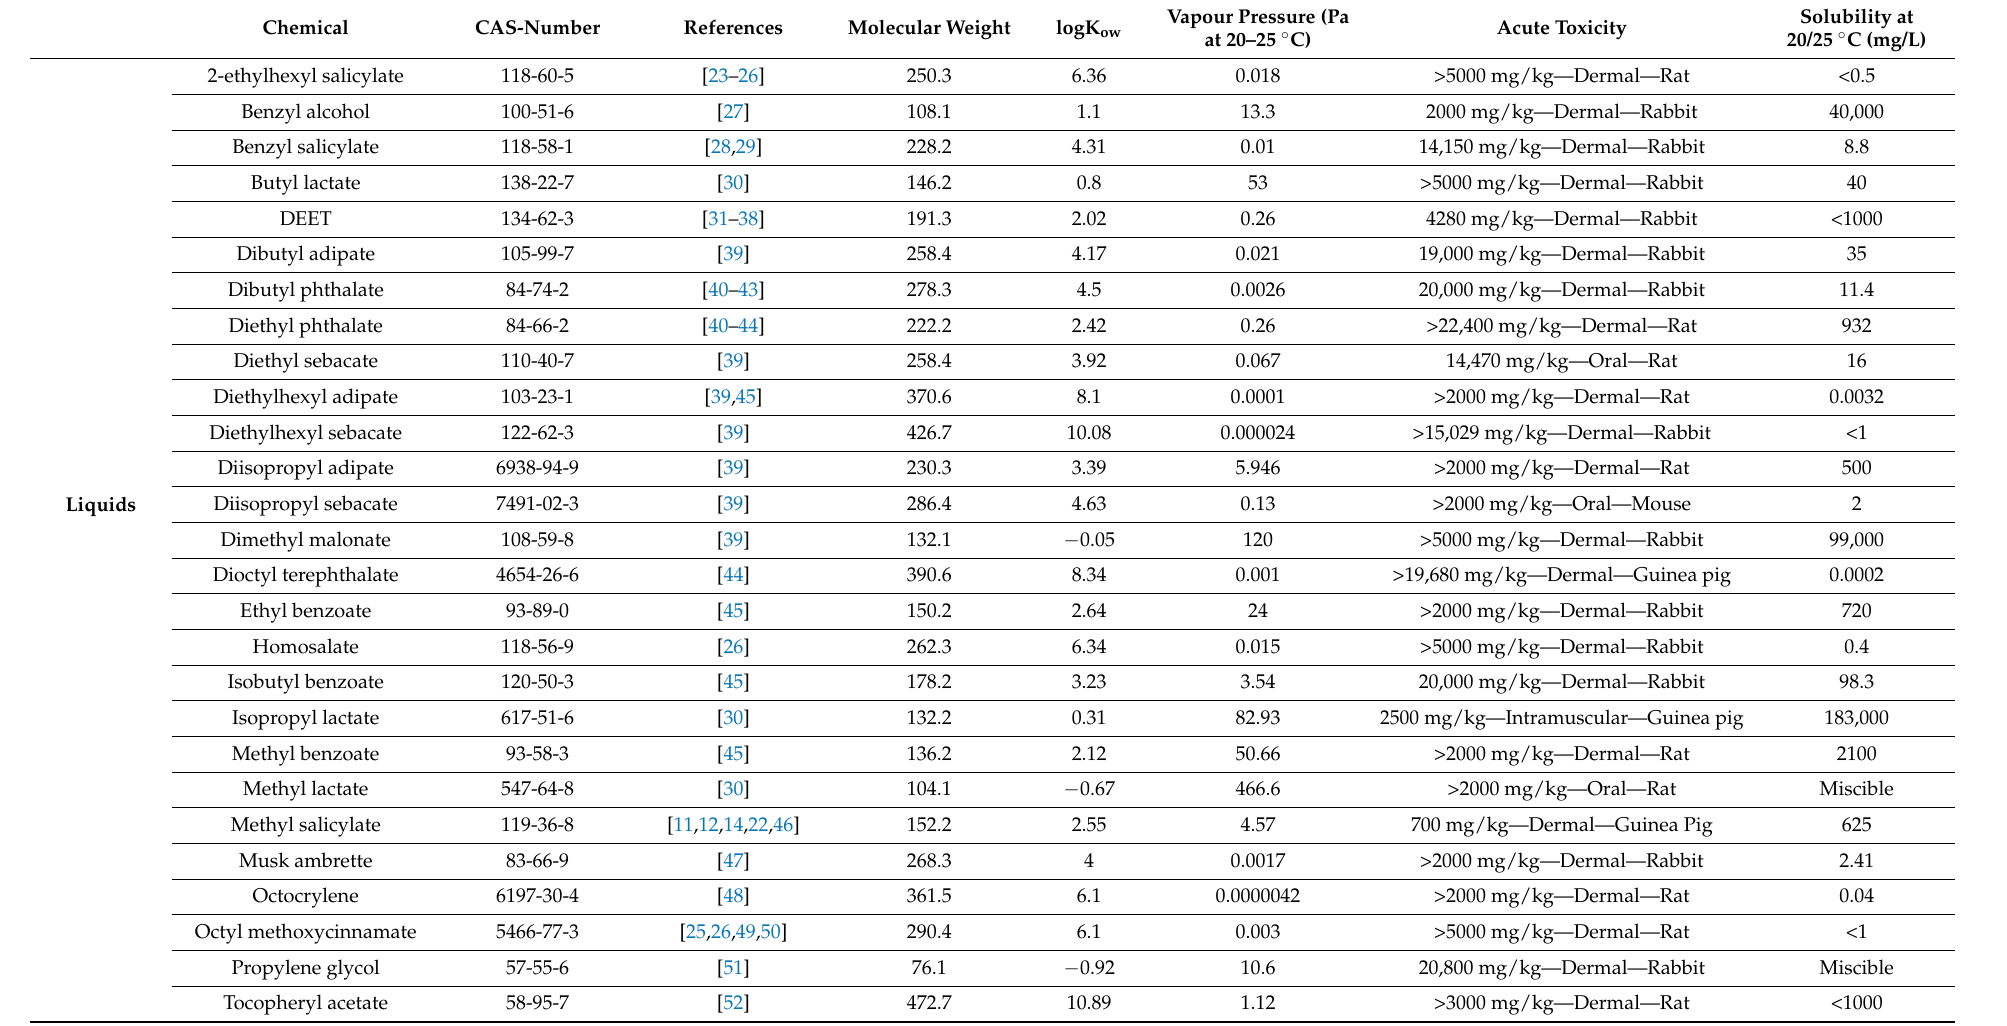
Table 4. Full list of the chemicals in the green category and their physicochemical properties. The table is divided by state at room